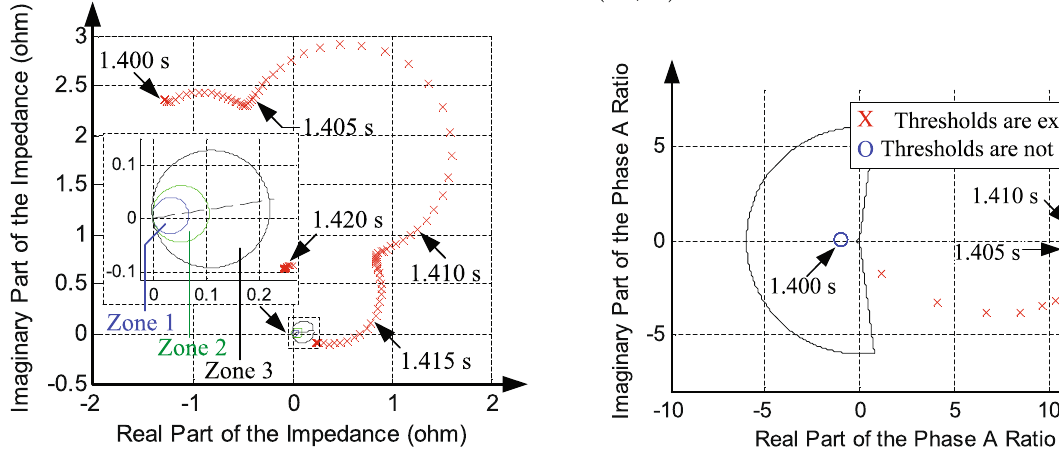
Fig. 5 Calculated impedance trace of event 1: internal bolted fault, grid-connected mode